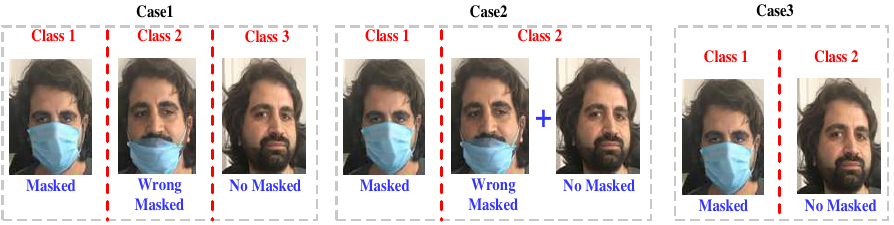
Figure 5. Test cases used in the study.